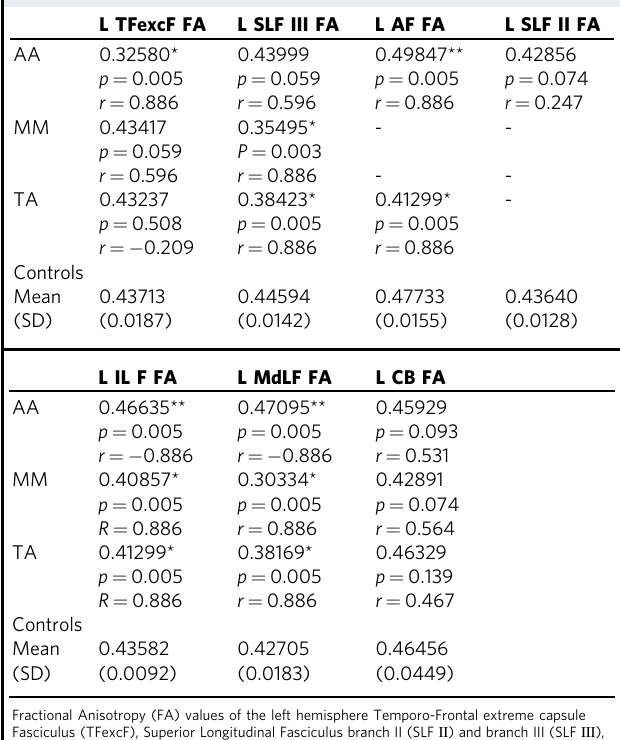
Table 1 Presentation of the Fractional Anisotropy (FA) values of the white matter fasciculi reconstructed for the three patients and the control group.